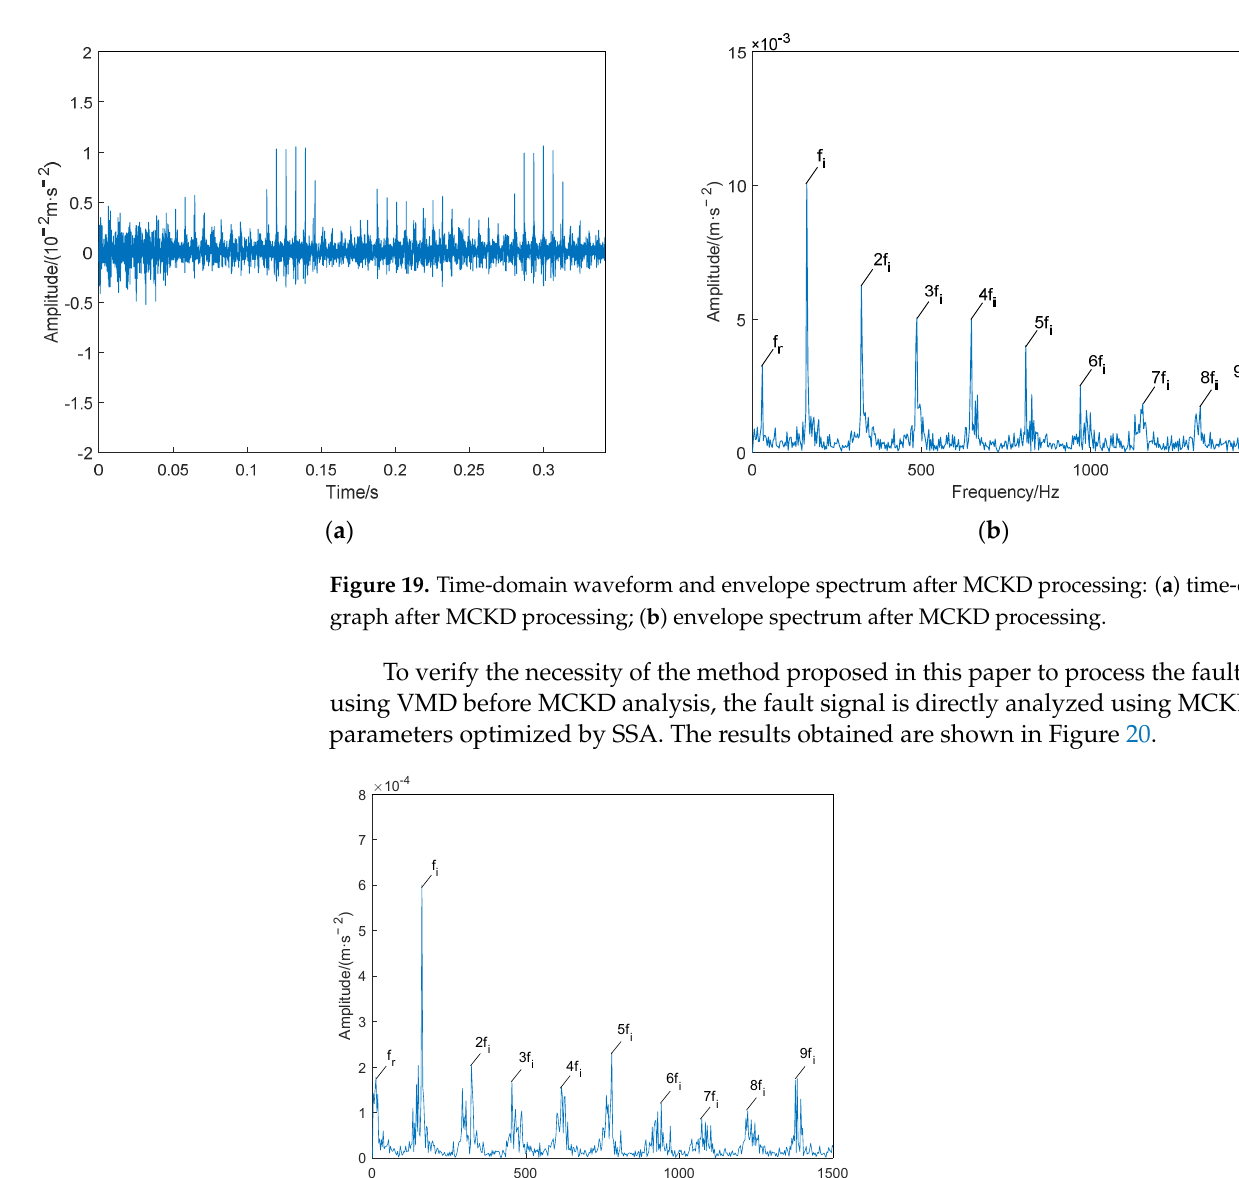
Figure 20. Envelope spectrum after direct SSA–MCKD processing.